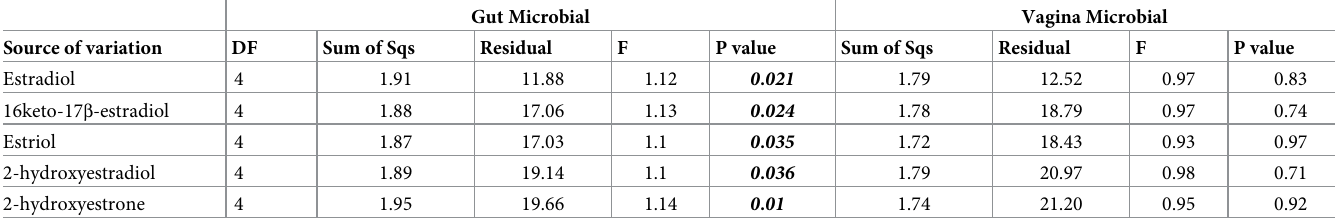
Statistically significant explanatory variables are in bold and